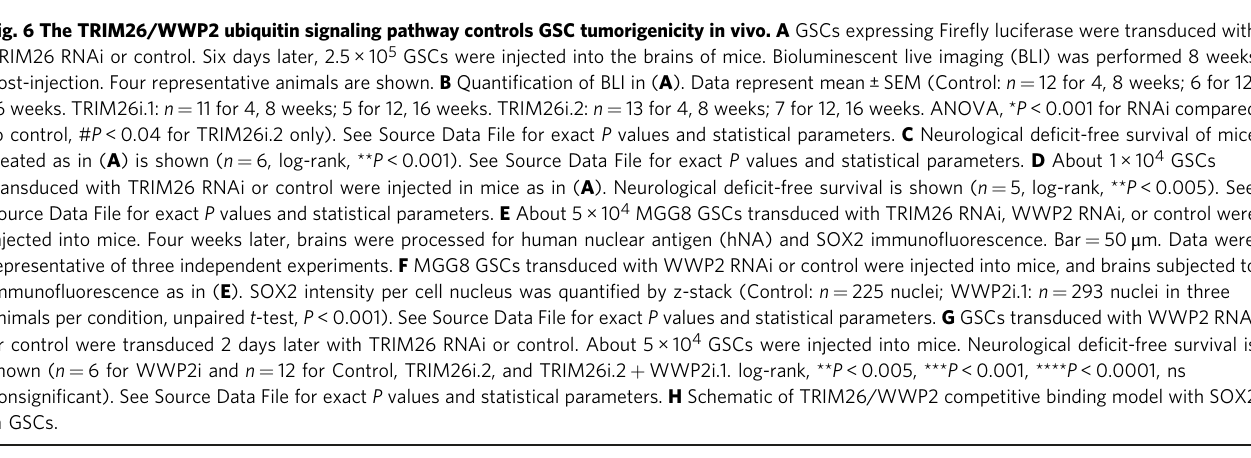
Fig. 6 The TRIM26/WWP2 ubiquitin signaling pathway controls GSC tumorigenicity in vivo. A GSCs expressing Fire fl y luciferase were transduced with TRIM26 RNAi or control. Six days later, 2.5 × 10 5 GSCs were injected into the brains of mice. Bioluminescent live imaging (BLI) was performed 8 weeks post-injection. Four representative animals are shown. B Quanti fi cation of BLI in ( A ). Data represent mean ± SEM (Control: n = 12 for 4, 8 weeks; 6 for 12, 16 weeks. TRIM26i.1: n = 11 for 4, 8 weeks; 5 for 12, 16 weeks. TRIM26i.2: n = 13 for 4, 8 weeks; 7 for 12, 16 weeks. ANOVA, * P < 0.001 for RNAi compared to control, # P < 0.04 for TRIM26i.2 only). See Source Data File for exact P values and statistical parameters. C Neurological de fi cit-free survival of mice treated as in ( A ) is shown ( n = 6, log-rank, ** P < 0.001). See Source Data File for exact P values and statistical parameters. D About 1 × 10 4 GSCs transduced with TRIM26 RNAi or control were injected in mice as in ( A ). Neurological de fi cit-free survival is shown ( n = 5, log-rank, ** P < 0.005). See Source Data File for exact P values and statistical parameters. E About 5 × 10 4 MGG8 GSCs transduced with TRIM26 RNAi, WWP2 RNAi, or control were injected into mice. Four weeks later, brains were processed for human nuclear antigen (hNA) and SOX2 immuno fl uorescence. Bar = 50 μ m. Data were representative of three independent experiments. F MGG8 GSCs transduced with WWP2 RNAi or control were injected into mice, and brains subjected to immuno fl uorescence as in ( E ). SOX2 intensity per cell nucleus was quanti fi ed by z-stack (Control: n = 225 nuclei; WWP2i.1: n = 293 nuclei in three animals per condition, unpaired t -test, P < 0.001). See Source Data File for exact P values and statistical parameters. G GSCs transduced with WWP2